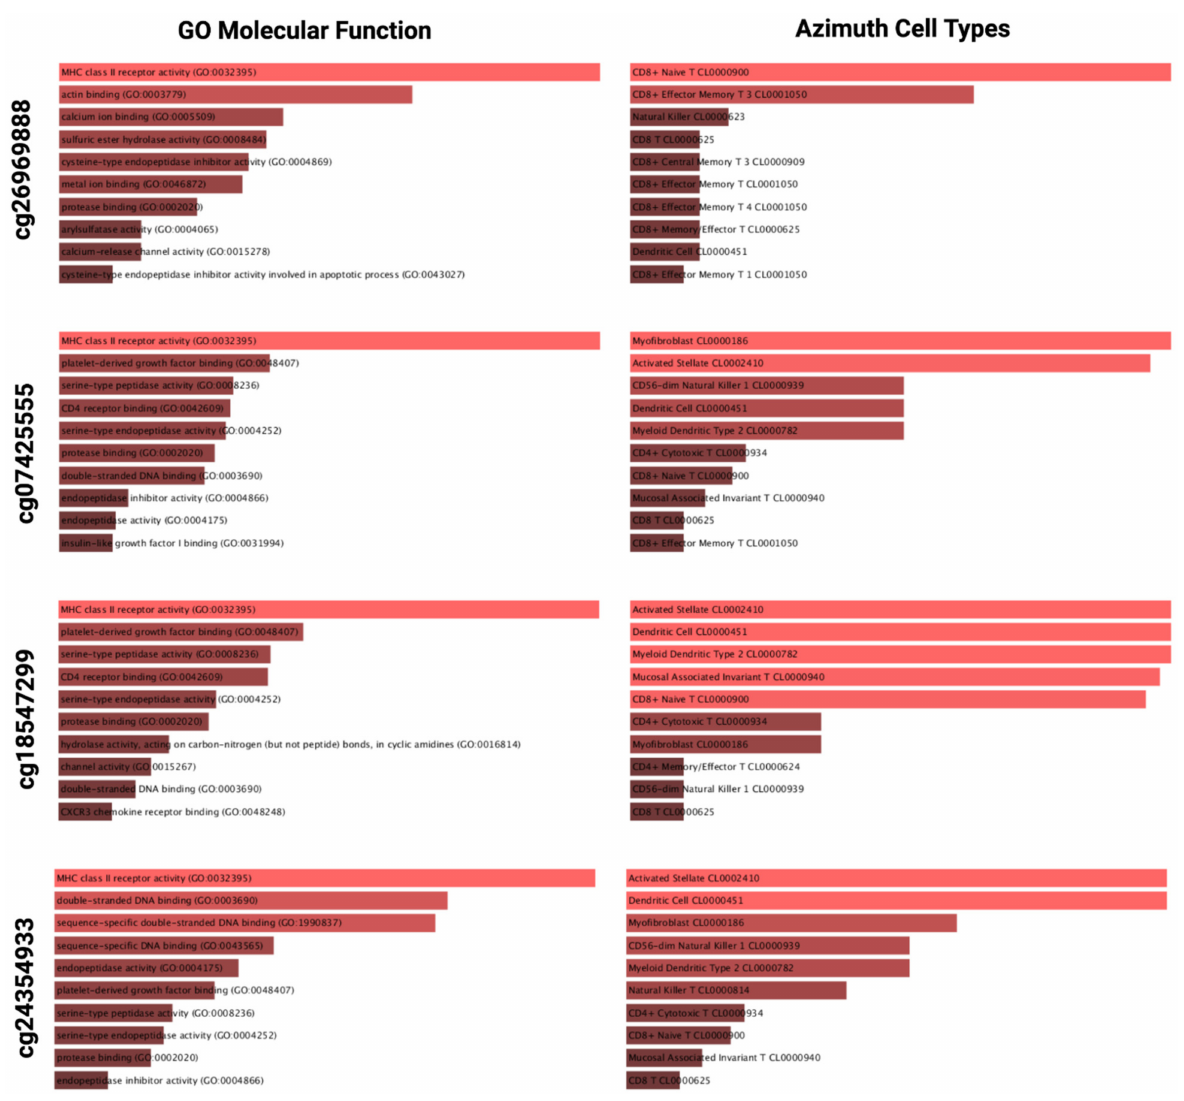
Figure 4. Gene Ontology (GO) molecular function and Azimuth cell type analysis using the top 1000 significantly upregu- lated genes (Benjamini–Hochberg false discovery rate < 0.01) in PODNL1 low methylation groups of four significant CpGs. Data represents − log10 p -values. All enriched terms have p -values <